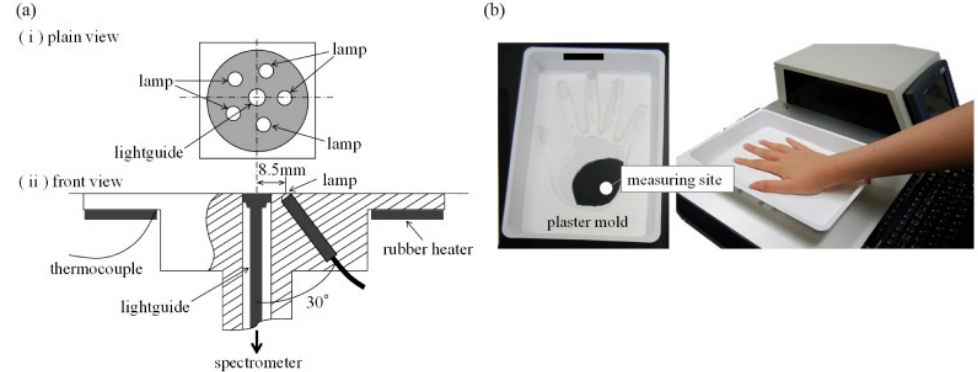
Figure 3. ( a ) Setup details. ( b ) A plaster mold to restrain a patient’s hand. Reprinted with permission from [68].